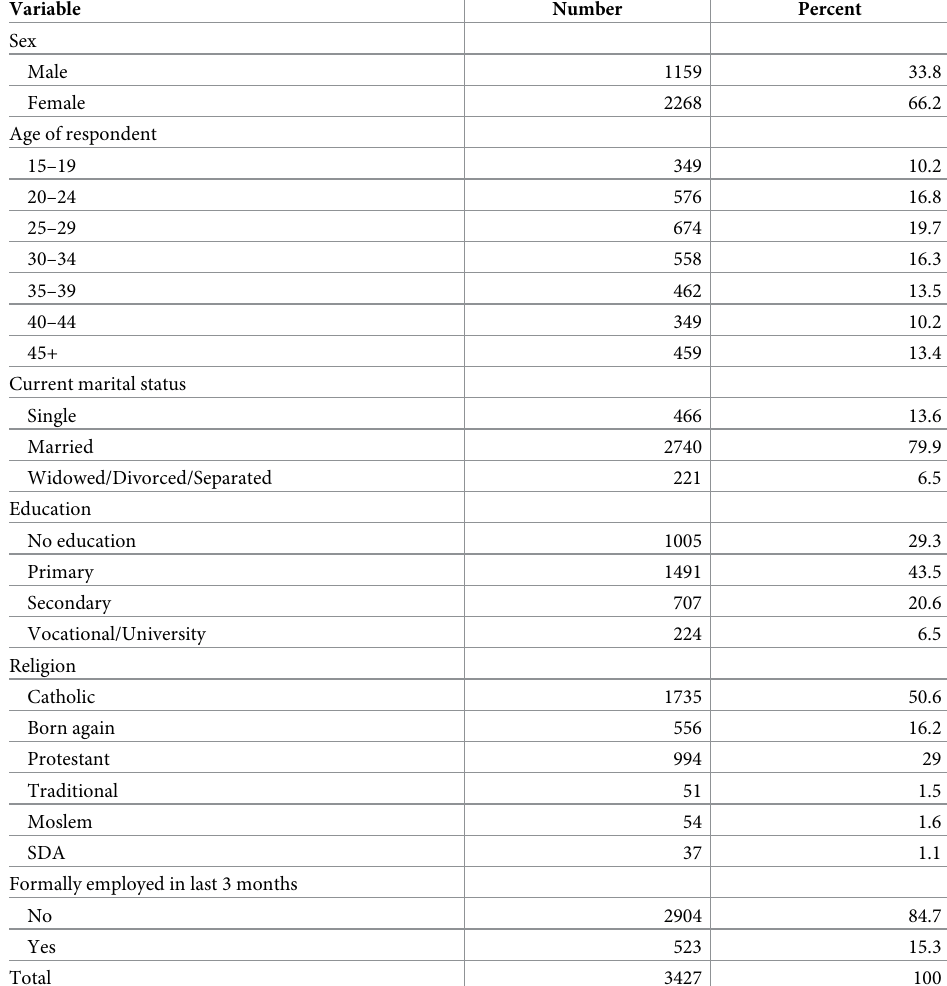
Table 1. Distribution of respondents by socio-economic and demographic